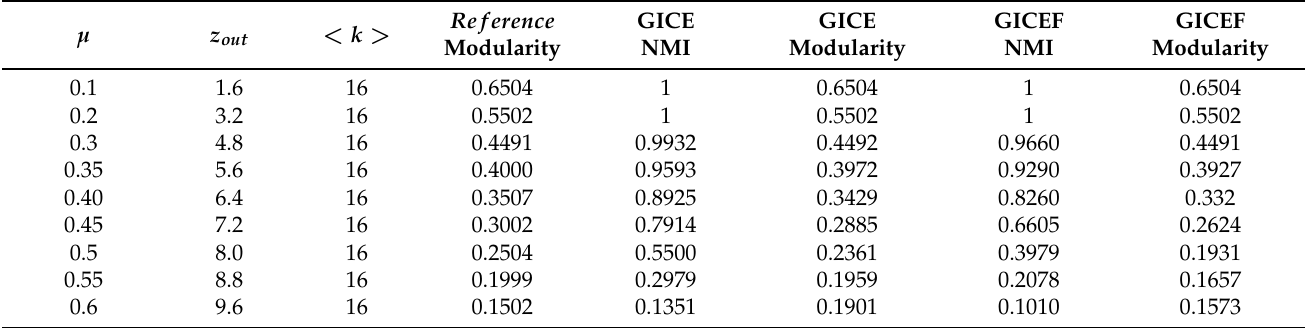
Table 10. Normalized Mutual Information (NMI) based on the mixing parameter µ = z out partition with four groups in the GN benchmark using the GICE and GICEF